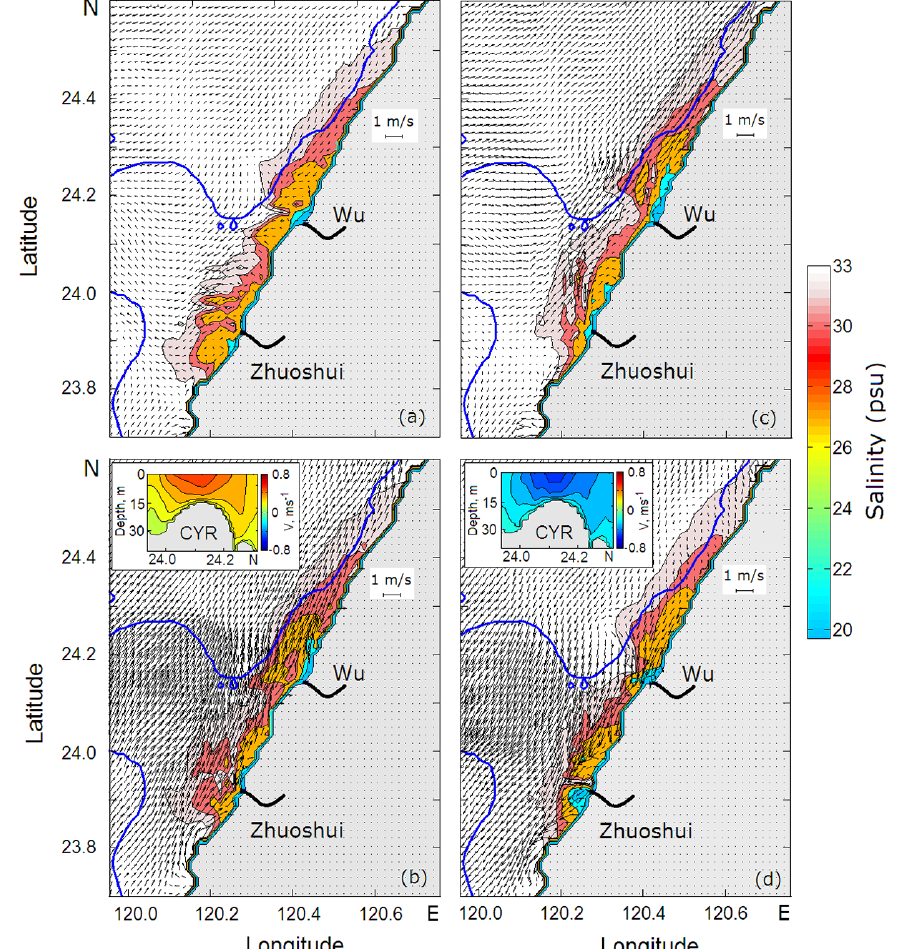
Figure 6. Successive phases of tidal velocity and salinity at 1m depth at (a) 08:00, (b) 11:00, (c) 14:00, and (d) 17:00GMT on 27 June 2013. The phases (b) and (d) correspond to the peak flood (northeastward) and ebb (southwestward) flows, respectively. The 30m isobath (solid blue line) approximately delineates the Chang-Yuen Ridge. The 32.5psu salinity contour delineates the river plumes. The insets in (b) and (d) show meridional velocity along 120 ◦ E above the ridge during the peak flood and ebb flows,